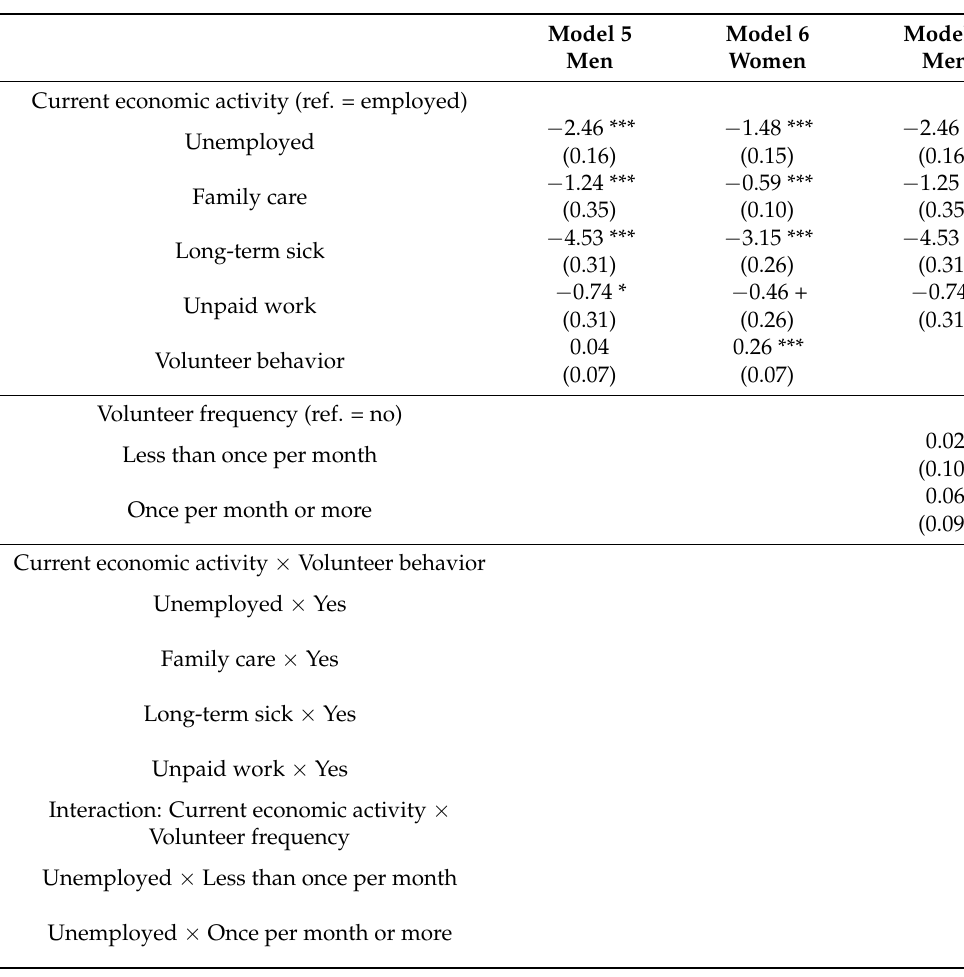
Table 3. Two-way fixed effects models predicting the effects of current economic activity type and voluntary participation on mental health (reversed GHQ − 12) for men and